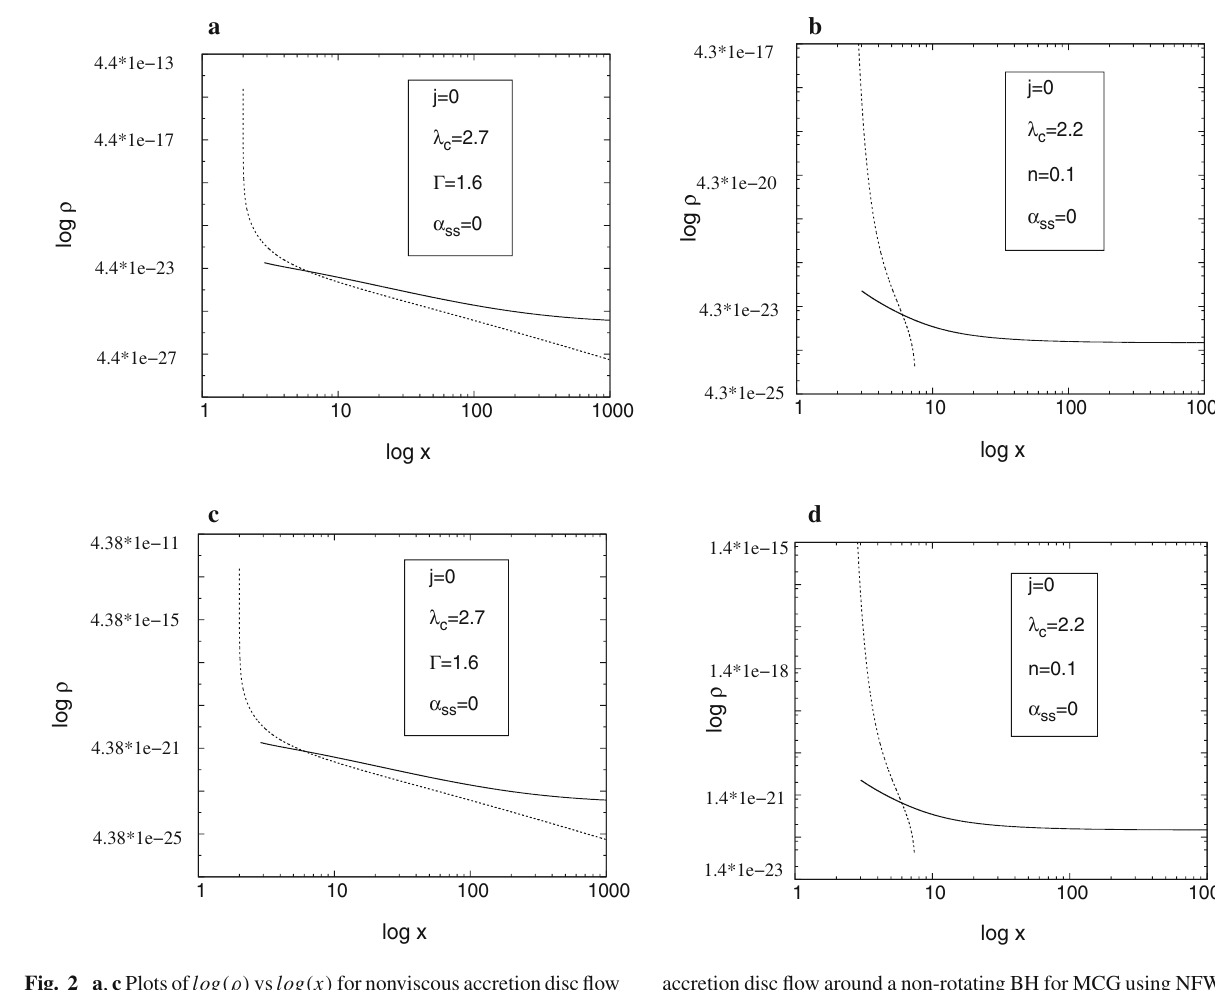
accretion disc flow around a non-rotating BH for MCG using NFW and Einasto profile respectively. Accretion and wind curves are depicted by solid and dotted lines